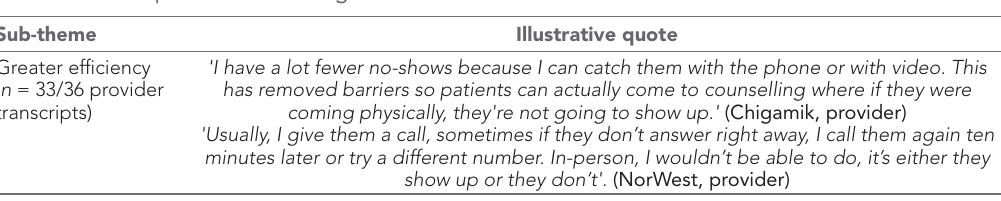
Table 4 Quadruple aim 3: reducing